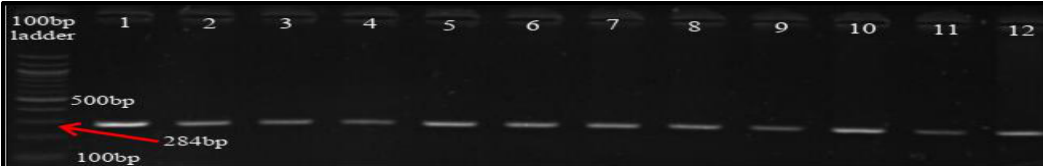
Figure 2. A representative P. shigelloides -specific 23S rDNA gel image. Line 1 = Positive control ( P. shigelloides DSM 8224); lines 2 to 12 = positive